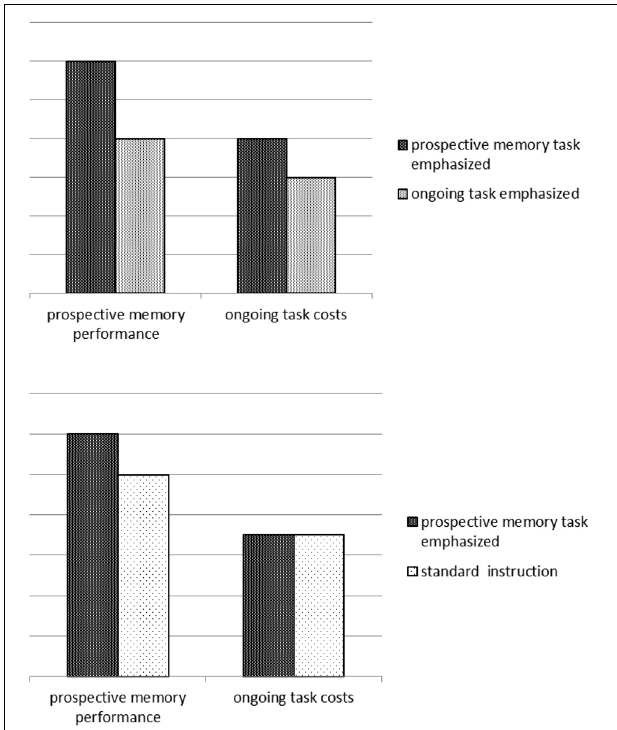
FIGURE 2 | Prospective memory performance and ongoing task costs for studies on relative performance (top) and possible outcome for absolute importance manipulations